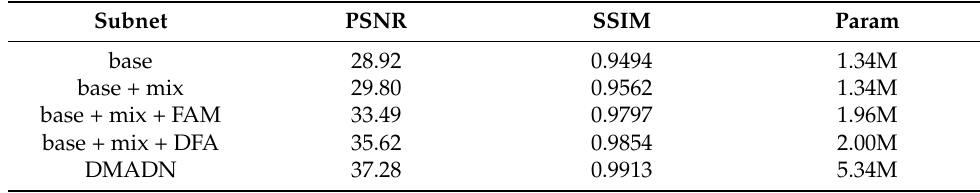
Table 3. Ablation study on DMADN.